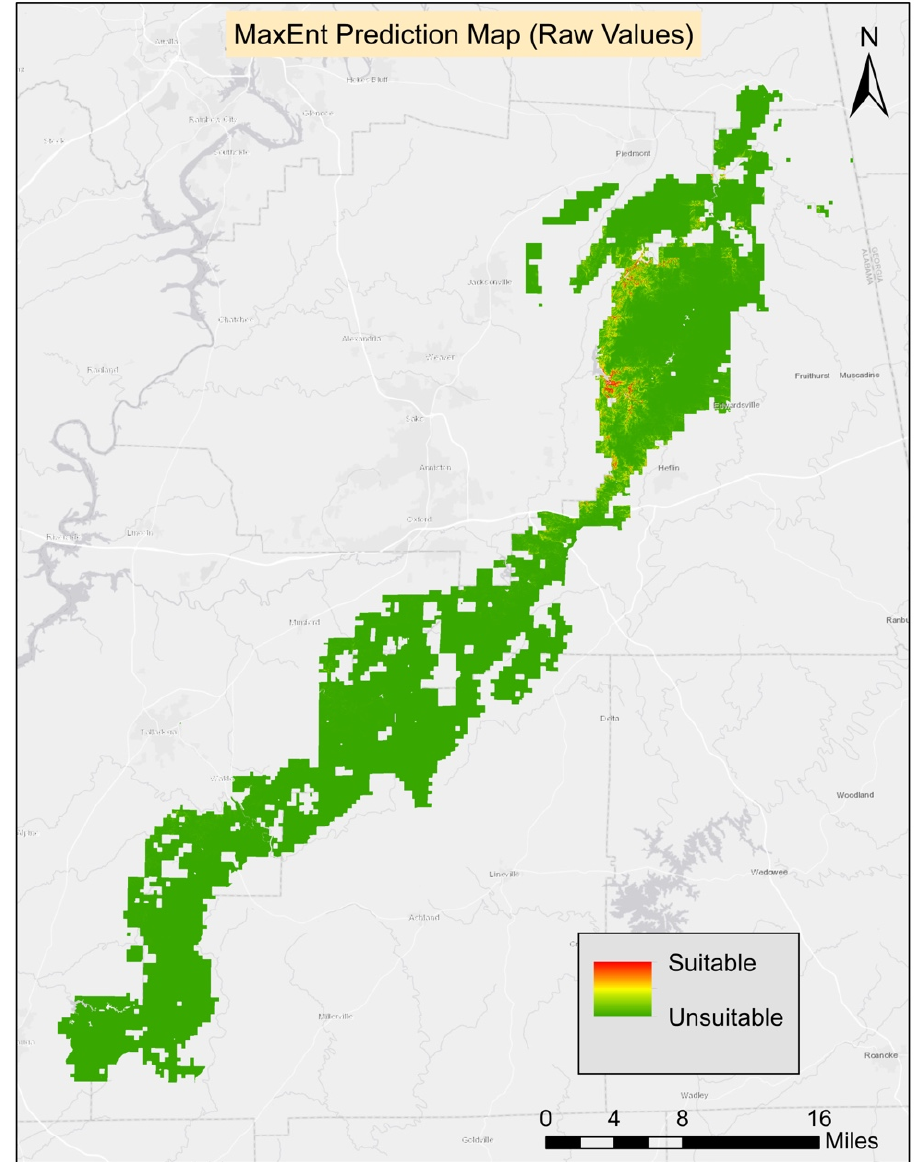
Figure A4. Xerophyllum asphodeloides (turkeybeard) MaxEnt model habitat suitability map.